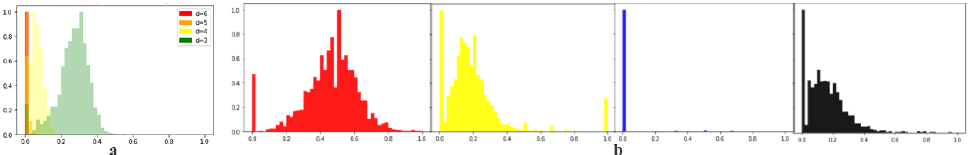
Figure 11. IOU ( a ) histograms between IGN and OSM data 2019–2020, with varying d . ( b ) IOU histograms for matching graph geographic areas obtained for Meurthe-en-Moselle department for two graph sources (IGN 2019-OSM 2020) and 4 different categories: red—ordinary buildings, yellow—all buildings (including monuments), blue—rivers and